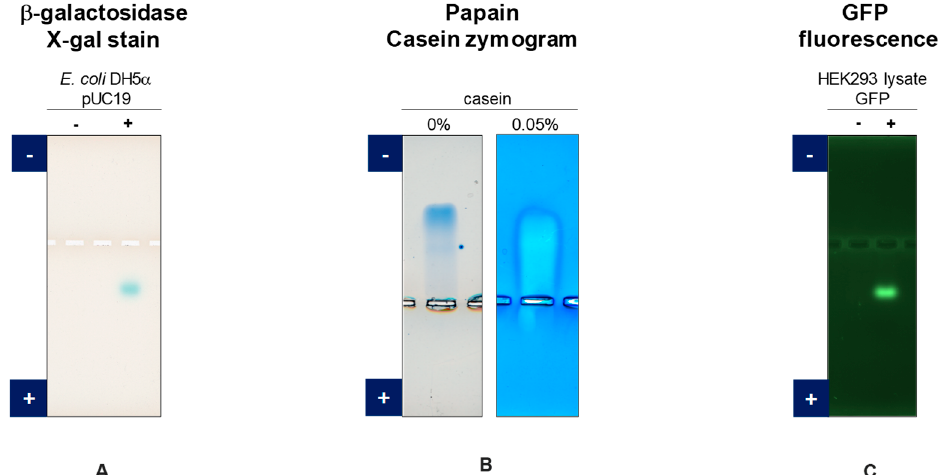
Figure 6. Zymography of enzymes and GFP fluorescence separated by agarose native gel electrophoresis. ( A ) Expression of β -galactosidase in E. coli DH5 α without ( − ) and with (+) pUC19 expression. ( B ) Papain zymography. Left, CBB staining. Right, zymogram with casein as a substrate. ( C ) GFP fluorescence in HEK293 cell lysates without expression ( − ) and with expression (+).